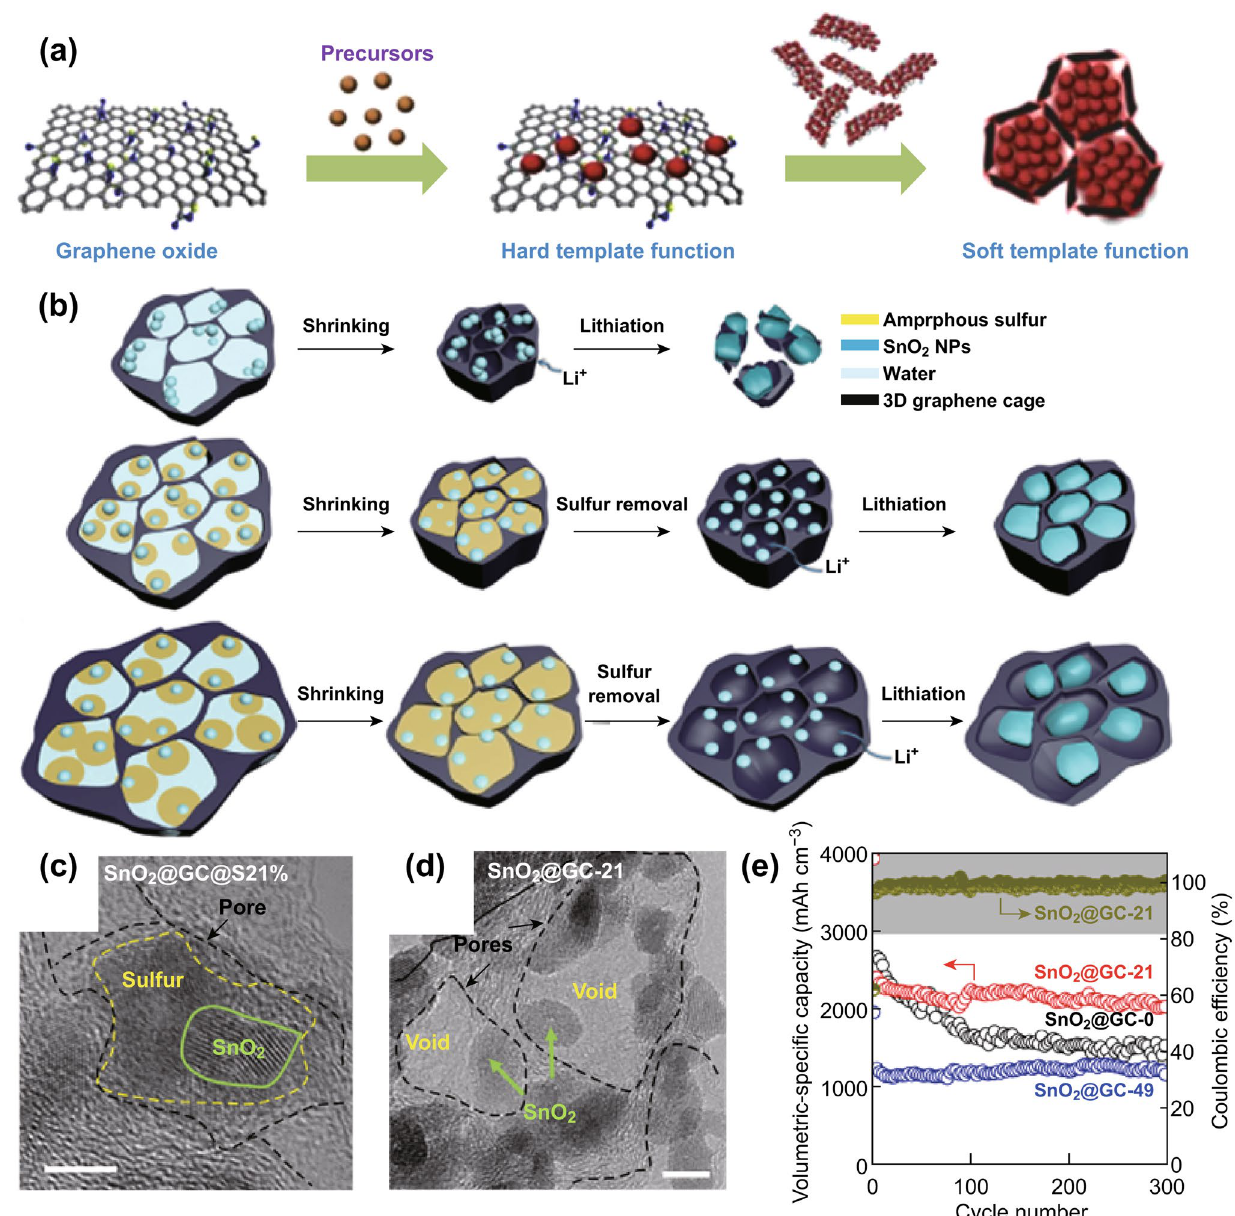
Fig. 7 a Schematic of in situ nanocrystal growth with GO as both hard and soft templates. Reprinted with permission from Ref. [108]. b Sche‑ matic of the sulfur‑template control strategy that incorporates void space. HRTEM image of SnO 2 @GC: c before sulfur removal and d after removal of all of the original sulfur (Scale bar: 5 nm). e Cycling performance. Reprinted with permission from Ref.